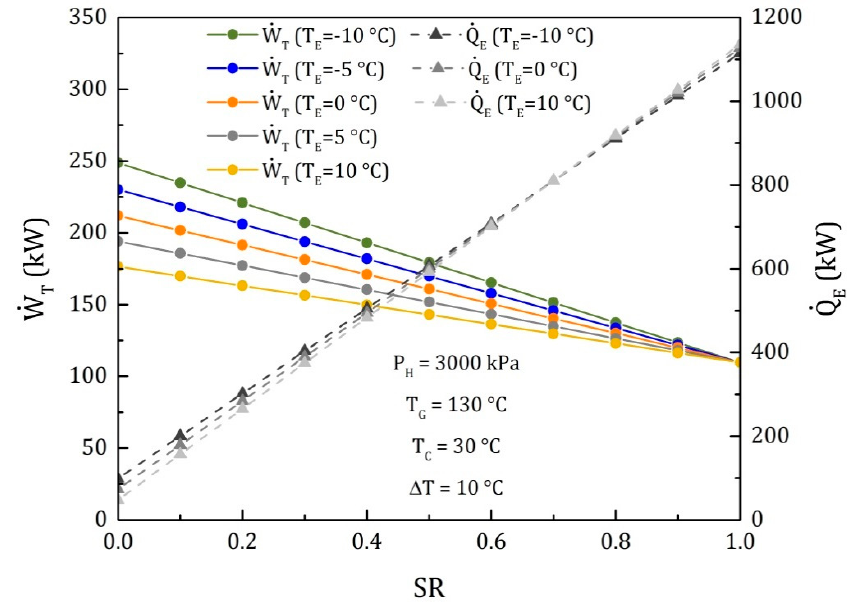
. . Figure 9. W T and Q E as a function of SR for Model III for di ff erent evaporator temperatures. Figure 9. W(cid:4662) (cid:2904) and Q(cid:4662) (cid:2889) as a function of SR for Model III for different evaporator temperatures. Figure 9. W(cid:4662) (cid:2904) and Q(cid:4662) (cid:2889) as a function of SR for Model III for different evaporator temperatures.